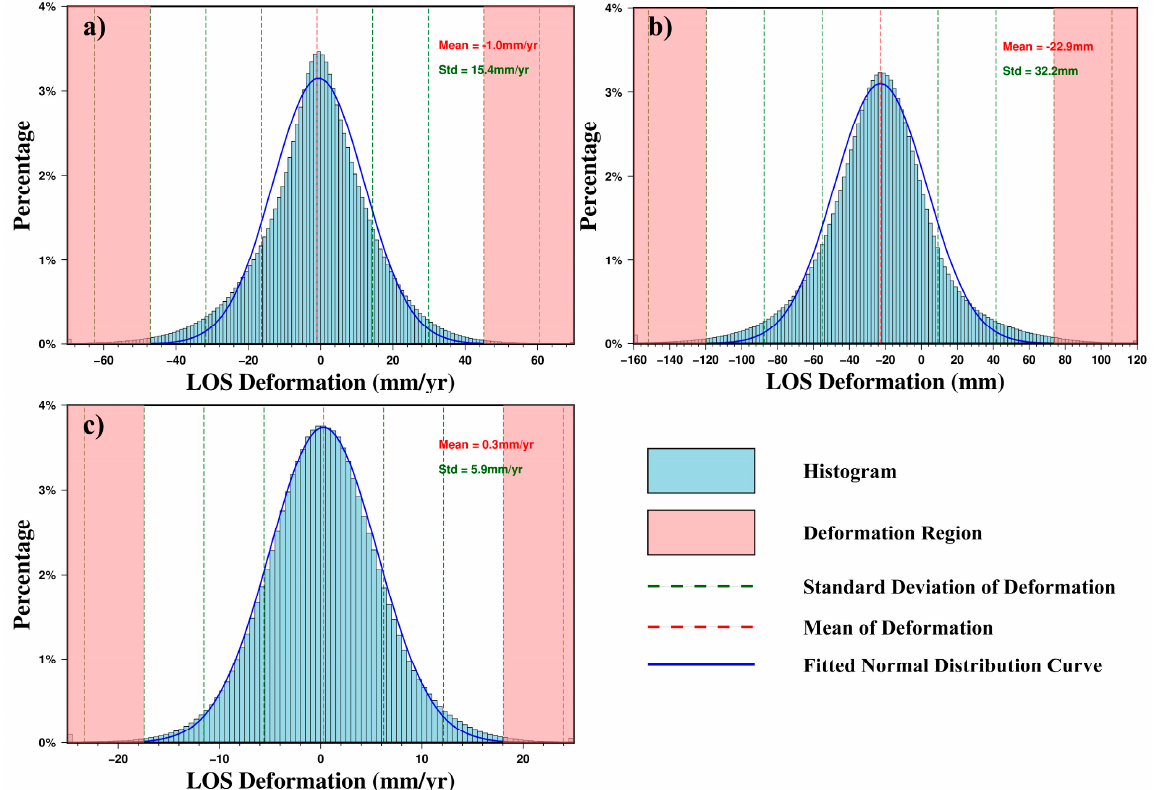
Figure 12. Distribution histogram of three deformation maps and its fitted normal distribution curve. ( a ) Annual velocity map obtained by SBAS. ( b ) Time-series cumulative displacement map obtained by SBAS. ( c ) Annual velocity map obtained by stacking.